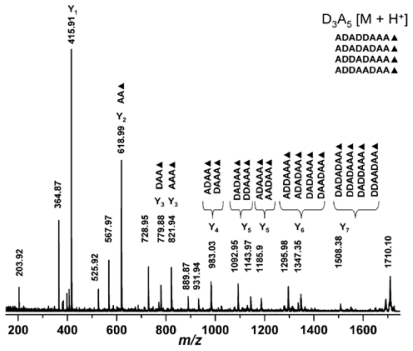
MALDI-TOF/TOF-MS/MS of AMAC derivatized D3A5 sugar 1711.80 m/z (▴ - AMAC). Reprinted from Carbohydrate Polymers 74, 2008, Cederkvist, F.H., Parmer, M.P., Vårum, K.M., Eijsink, V.G.H., Sørlie, M., Inhibition of a family 18 chitinase by chitooligosacharides, 41–49, Copyright (2010), with permission from Elsevier [229].